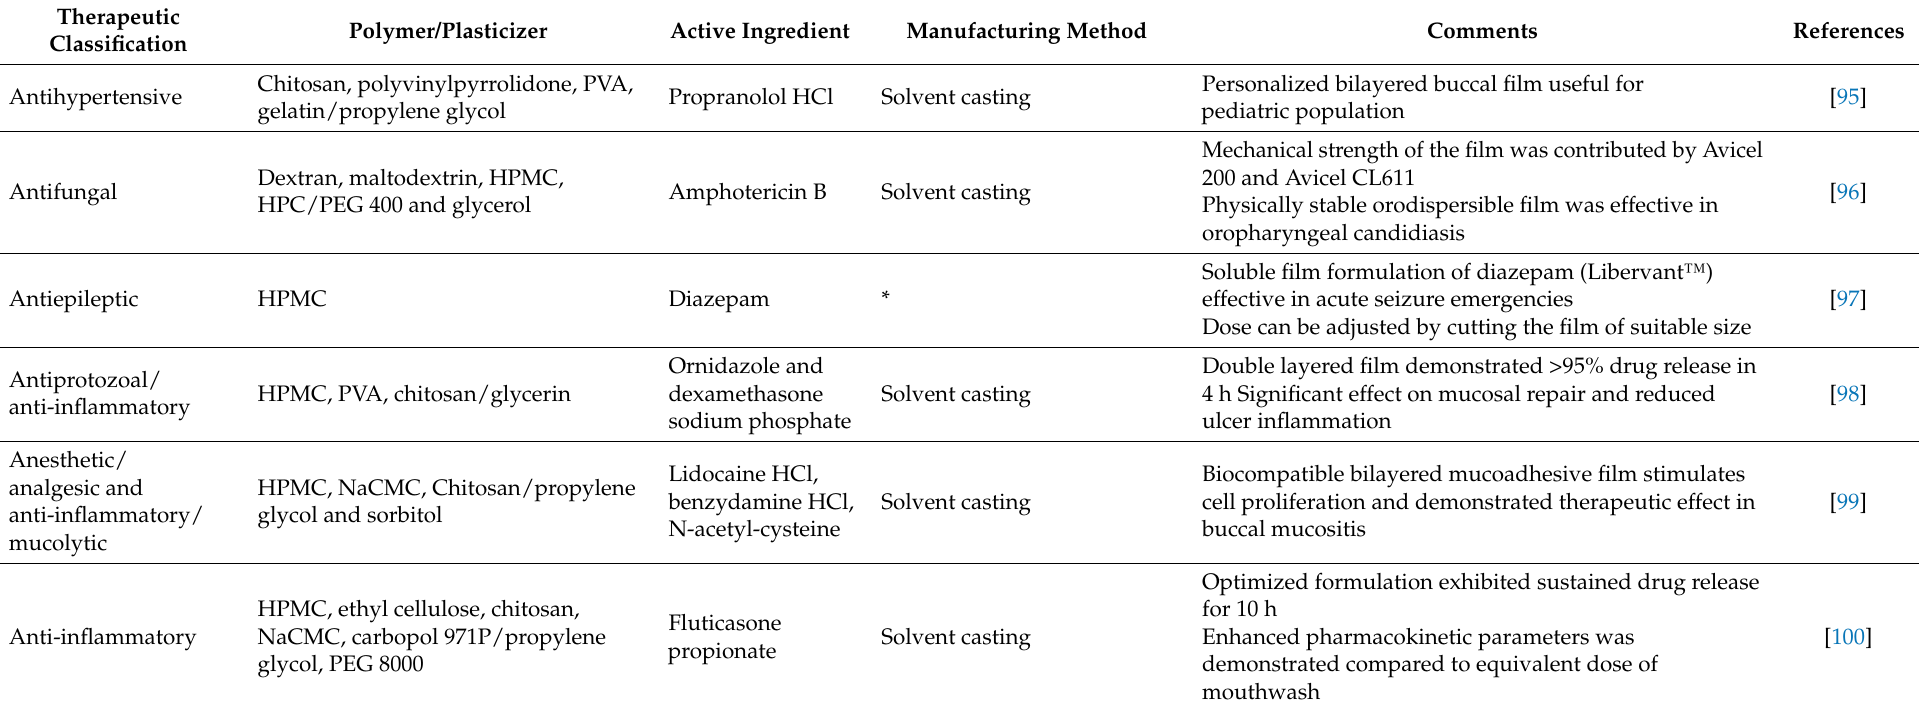
Table 3. Examples of mucoadhesive buccal films based on their therapeutic